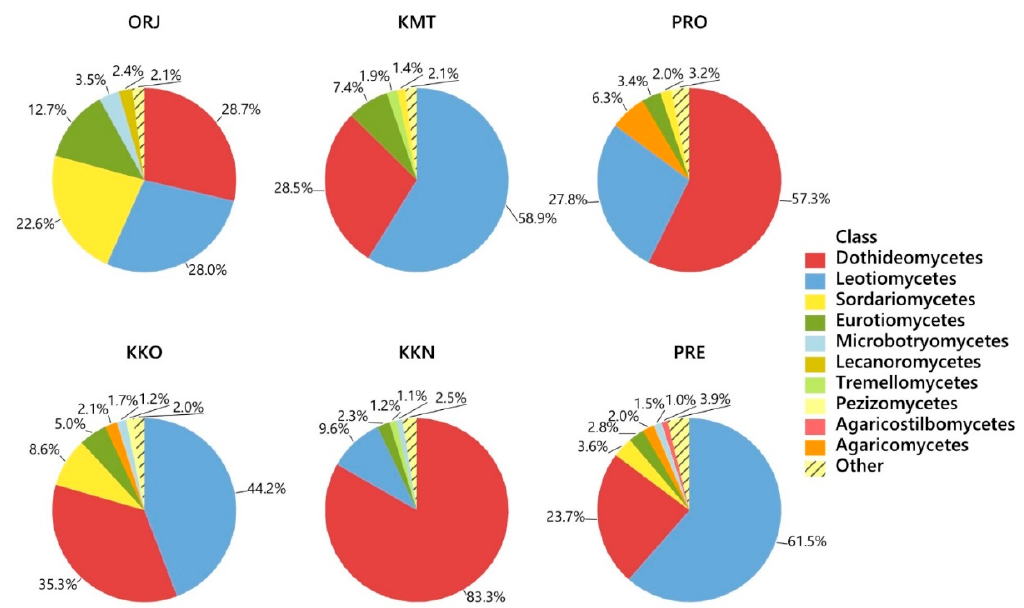
Figure 4. Relative abundance of different fungal classes in needles of Pinus heldreichii from six different sites in Montenegro. Classes comprising <1.0% of relative abundance for a given set of sequences were combined and shown as other. Sites are as in Table 1.